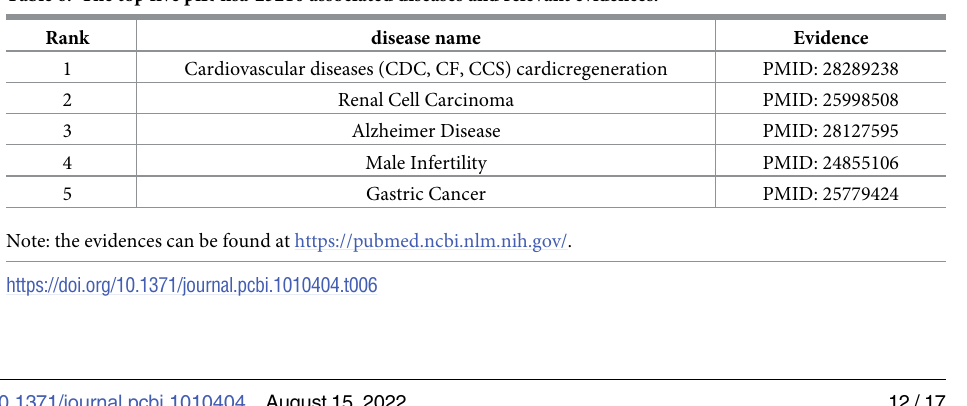
dataset and S p dataset, respectively. ind ind